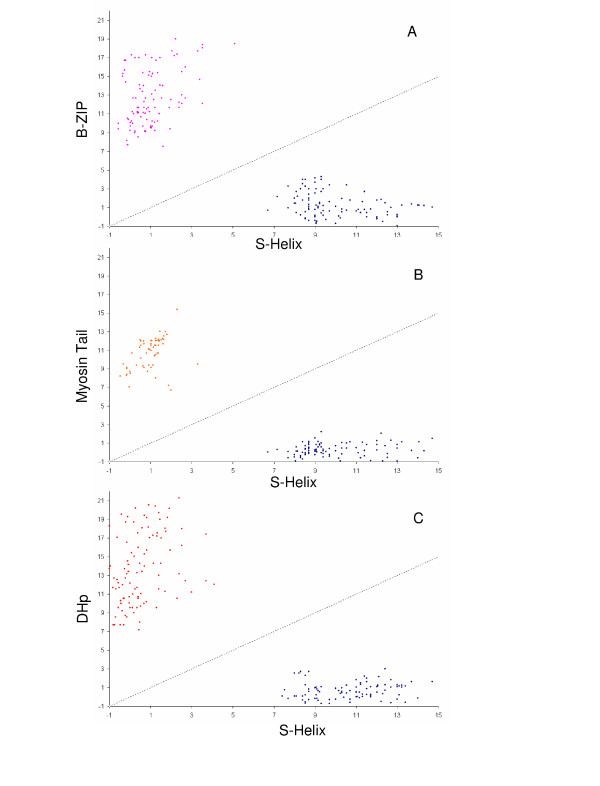
"Cross-hit" plots for the S-helix vis-à-vis examples of various parallel and anti-parallel CCs. The axes indicate the negative log of E-values from RPS-BLAST searches as a measure of significance. Typical S-helix and b-ZIP, Myosin tail domain or DHp domains are evident as two separated clusters, with no sequences having significant scores with both profiles. The blue dots in all the three graphs are plots of negative log of e-values from RPS-BLAST of S-helix database with S-Helix profile (x1) and of negative log of e-values from RPS-BLAST of S-helix database with bZIP, Myosin Tail domain or DHp profiles (y1). A) The pink dots are plots of negative log of e-values from RPS-BLAST of bZIP database with S-Helix profile (x2) and of negative log of e-values from RPS-BLAST of bZIP database with bZIP profiles (y2). B) The orange dots are plots of negative log of e-values from RPS-BLAST of Myosin Tail domain database with S-Helix profile (x2) and of negative log of e-values from RPS-BLAST of Myosin Tail domain database with Myosin Tail domain profiles (y2). C) The red dots are plots of negative log of e-values from RPS-BLAST of DHp domain database with S-Helix profile (x2) and of negative log of e-values from RPS-BLAST of DHp domain database with DHp domain profiles (y2).